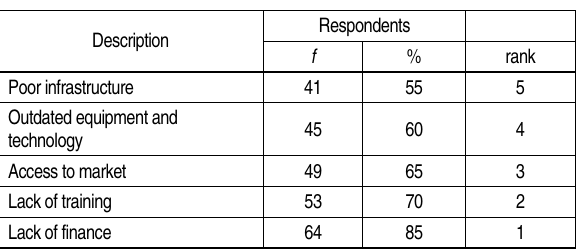
Table 6. Ranking of barriers to development of